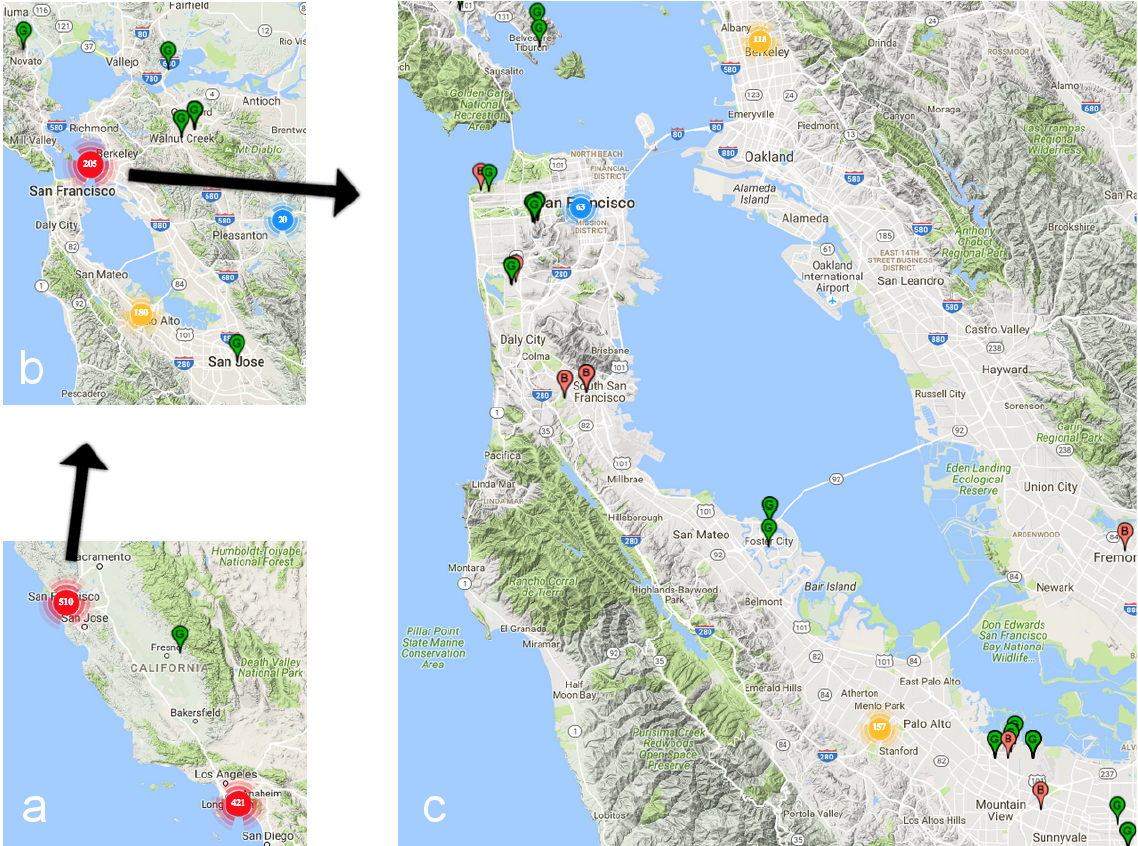
Figure 3: San Francisco Bay Area geographic locations of biological databases and tools: a) San Francisco Bay plus neighborhood and Los Angeles plus neighborhood; b) San Francisco neighborhood only; c) San Francisco Bay